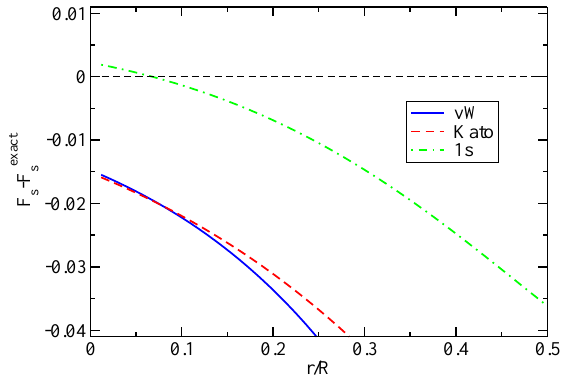
Figure 1. Error on the kinetic enhancement factor F s − F exact s versus the scaled radial distance r / R near the nucleus of the Kr atom.